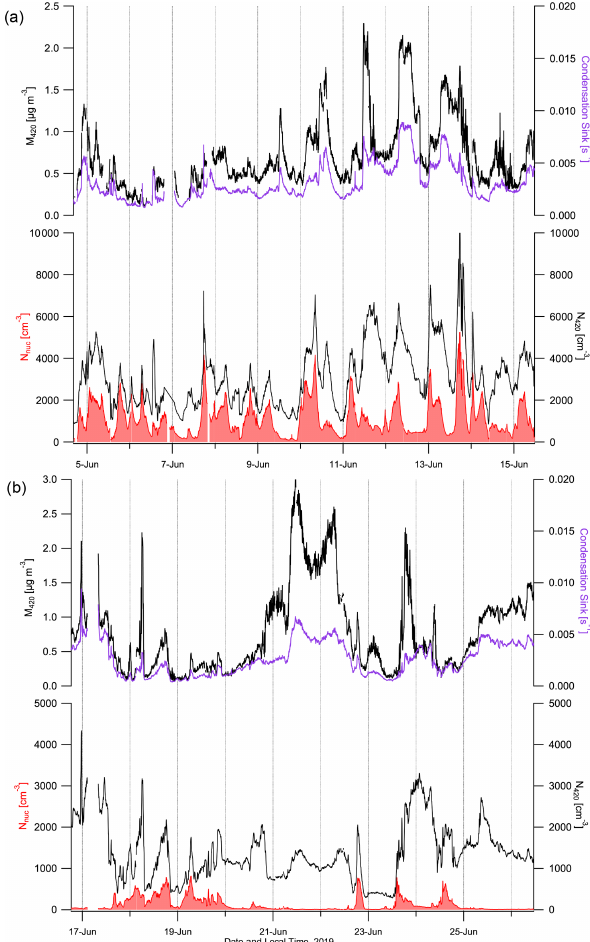
Figure 4. Mass and number concentrations of aerosol particles < 420nm ( M 420 and N 420 ), number concentrations of nucleation- mode particles < 24nm ( N nuc ), and condensation sink at (a) Eagle Lake and (b) Nazko